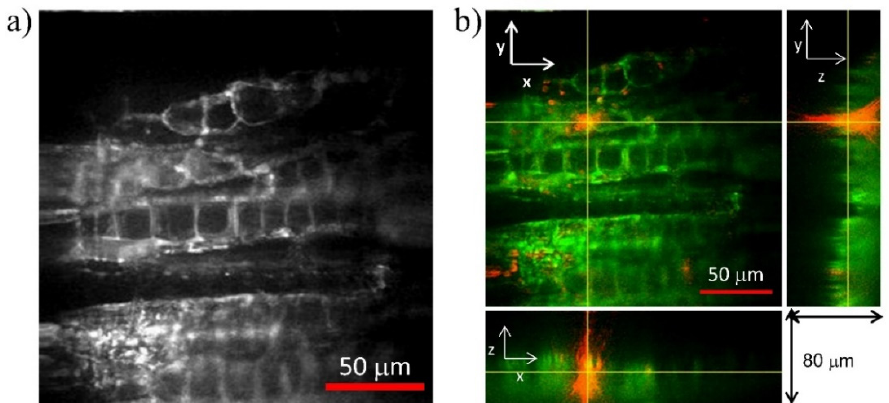
Figure 6. ( a ) Greyscale NLO microscopy image of chestnut and ( b ) orthogonal views of a merged TPEF/SHG image stack showing the presence of isolated aggregates of material strongly emitting SHG signals (red-coded) and TPEF signals (green-coded) generated by lignin.